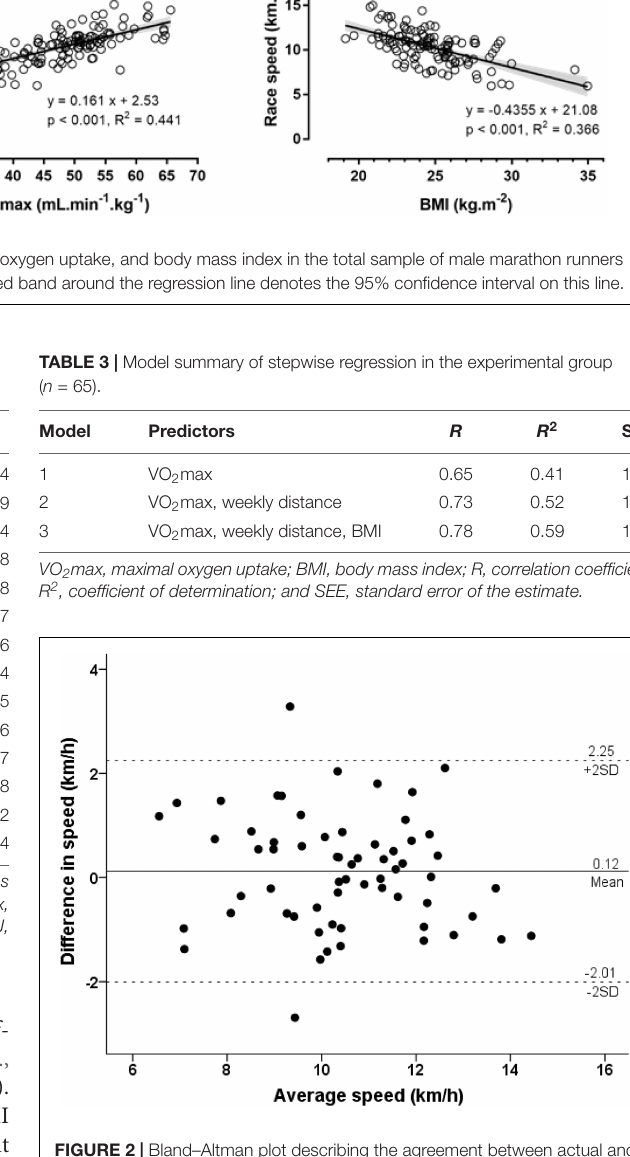
FIGURE 2 | Bland–Altman plot describing the agreement between actual and predicted race speed in the Athens marathon race. The Y -axis shows the difference between actual and predicted score, whereas the X -axis represents the average of actual and predicted